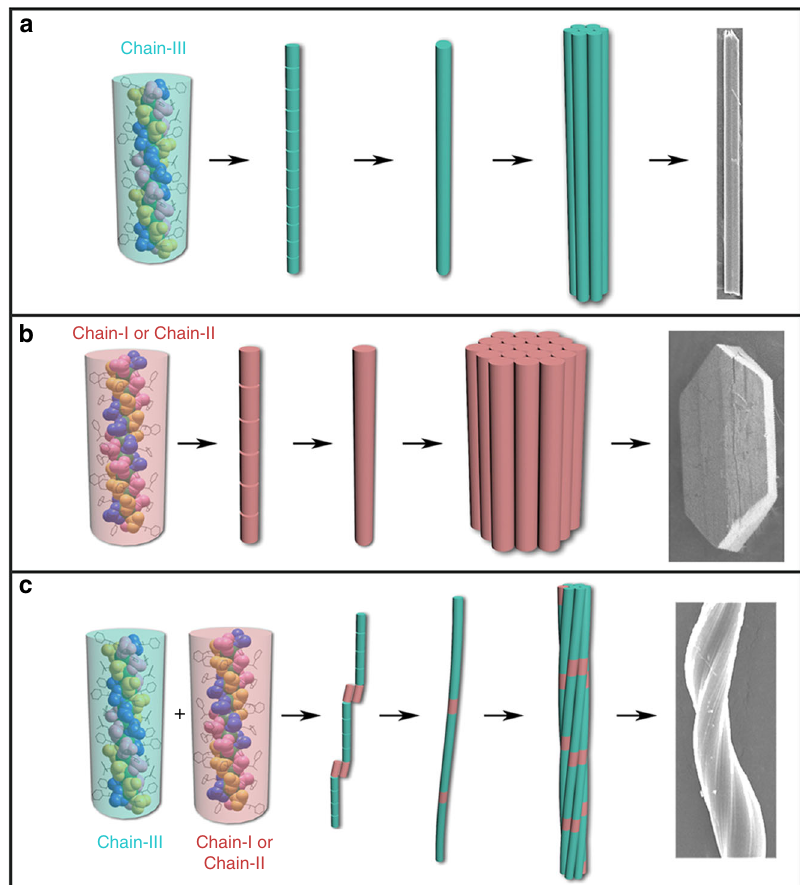
Fig. 10 Proposed formation mechanism of helices. Formation mechanisms of crystalline materials of R -3 ( a ) and R -2 ( b ), and helices of R -1 ( c